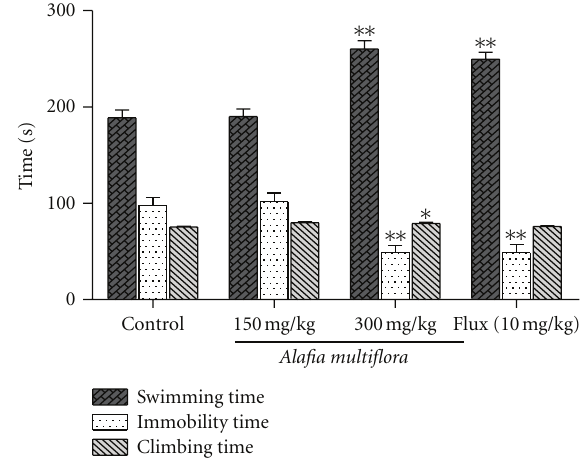
Figure 4: E ff ects of the aqueous extract of A. multiflora stem bark or fluoxetine on the forced swimming test in rats. Animals were treated with the extract (150 mg/kg or 300 mg/kg, i.p.) or distilled water once a day for 7 days. In the positive control, fluoxetine (Flux) was given only once (10mg/kg, i.p.) 30min prior to the test. Each column represents the mean ± SEM of 6 animals. Data analysis was performed using Dunnett’s t -test, ∗ P < 0 . 05; ∗∗ P < 0 . 01 significantly di ff erent from saline-treated